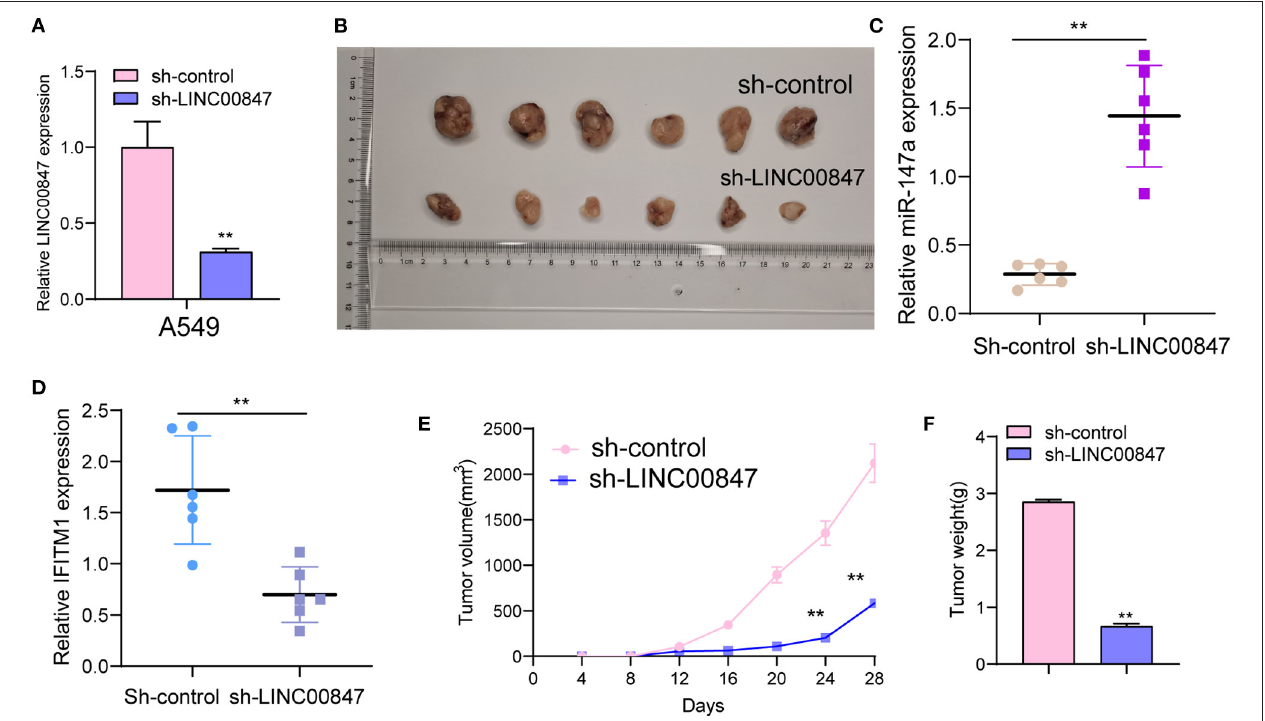
FIGURE 3 | LINC00847 promoted tumor growth in vivo . (A) The distinct knockdown of LINC00847 expression in A549 cells transfected with LINC00847 were demonstrated by RT-PCR. (B) Tumors derived from mice in two different groups were presented. (C, D) RT-PCR determined the expression of miR-147a and IFITM1 in tumors with sh-control and sh-LINC00847. (E) Tumor growth curves were shown every 7 days. (F) The subcutaneous tumor weights were detected at the 28th day after injection. ** p < 0.01.